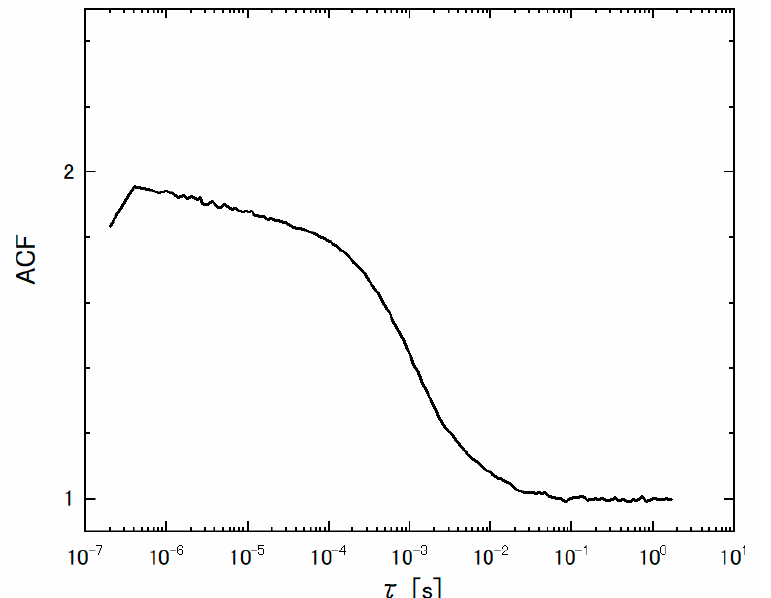
Figure A3. Autocorrelation function (ACF) measured by a conventional FCS system ( n = 1). The sample was of fluorescent latex beads with a diameter of 20 nm (FluoSpheres, F13081, Molecular Probes, USA). The measurement duration were 60 s. The excitation laser power at the focal plane of the focusing lens was 1.5 μ W.